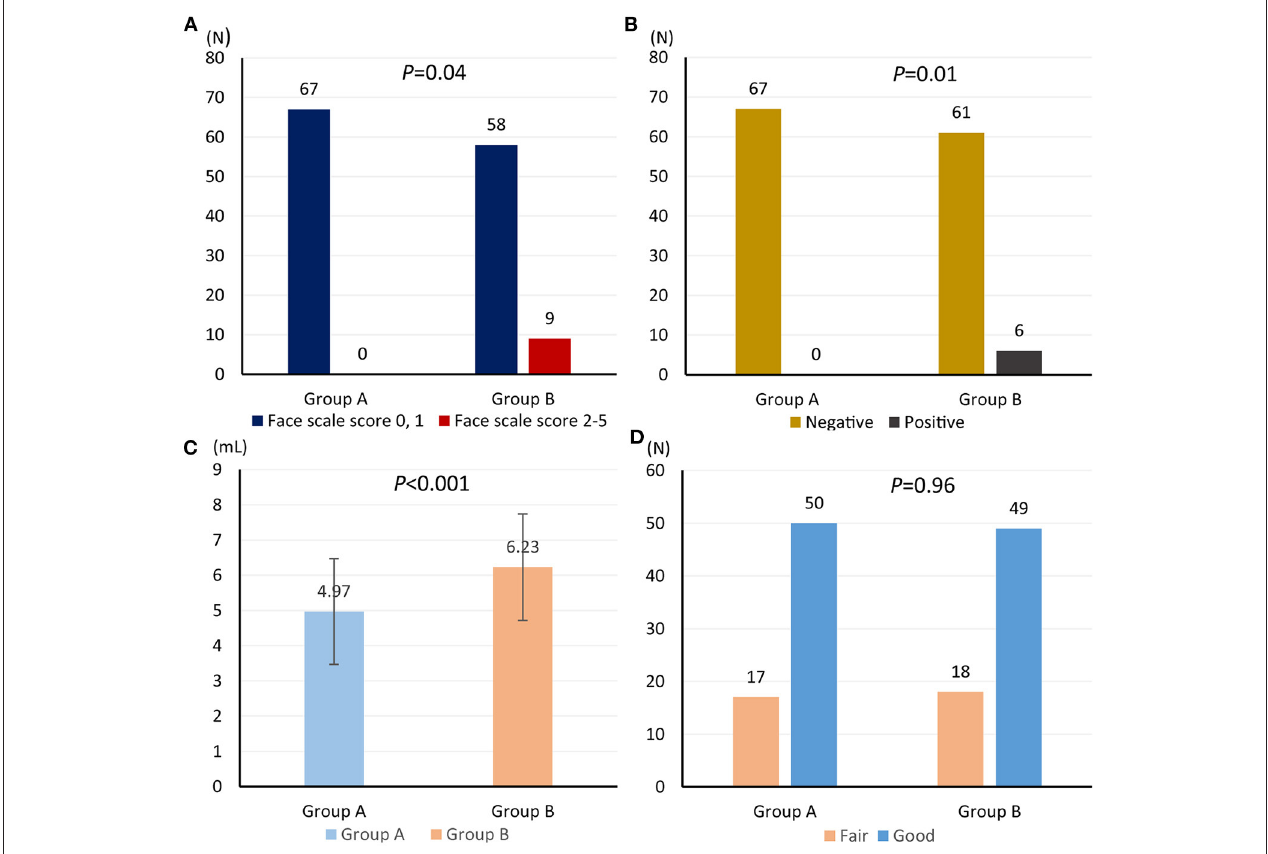
FIGURE 4 | Comparison of face scale score for heartburn and retrosternal pain (A) , starch indicator (B) , amount of iodine solution consumption (C) , and iodine-staining effect (D) from anterograde and retrograde iodine